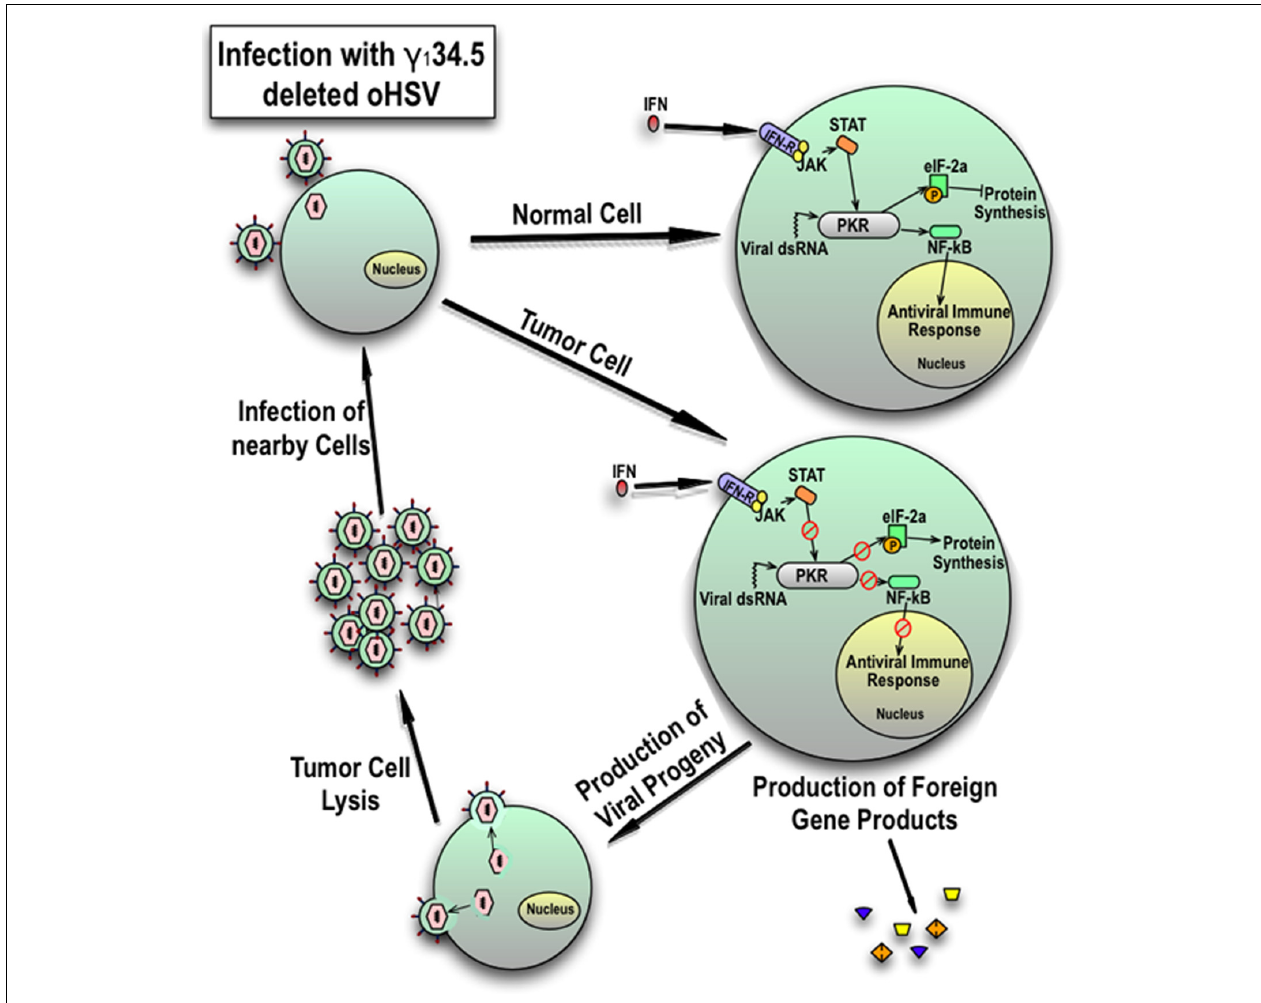
FIGURE 1 | Cellular response of normal cells and tumor cells to infection with γ 1 34.5-deleted HSV. In response to viral dsRNA and interferon signaling, an intact PKR response in normal cells inhibits protein synthesis and consequently late viral gene expression by phosphorylation of eukaryotic initiating factor 2 γ (eIF-2 γ ) and induces an antiviral response by activation of NF κ B. However, in tumor cells, the PKR mediated response is